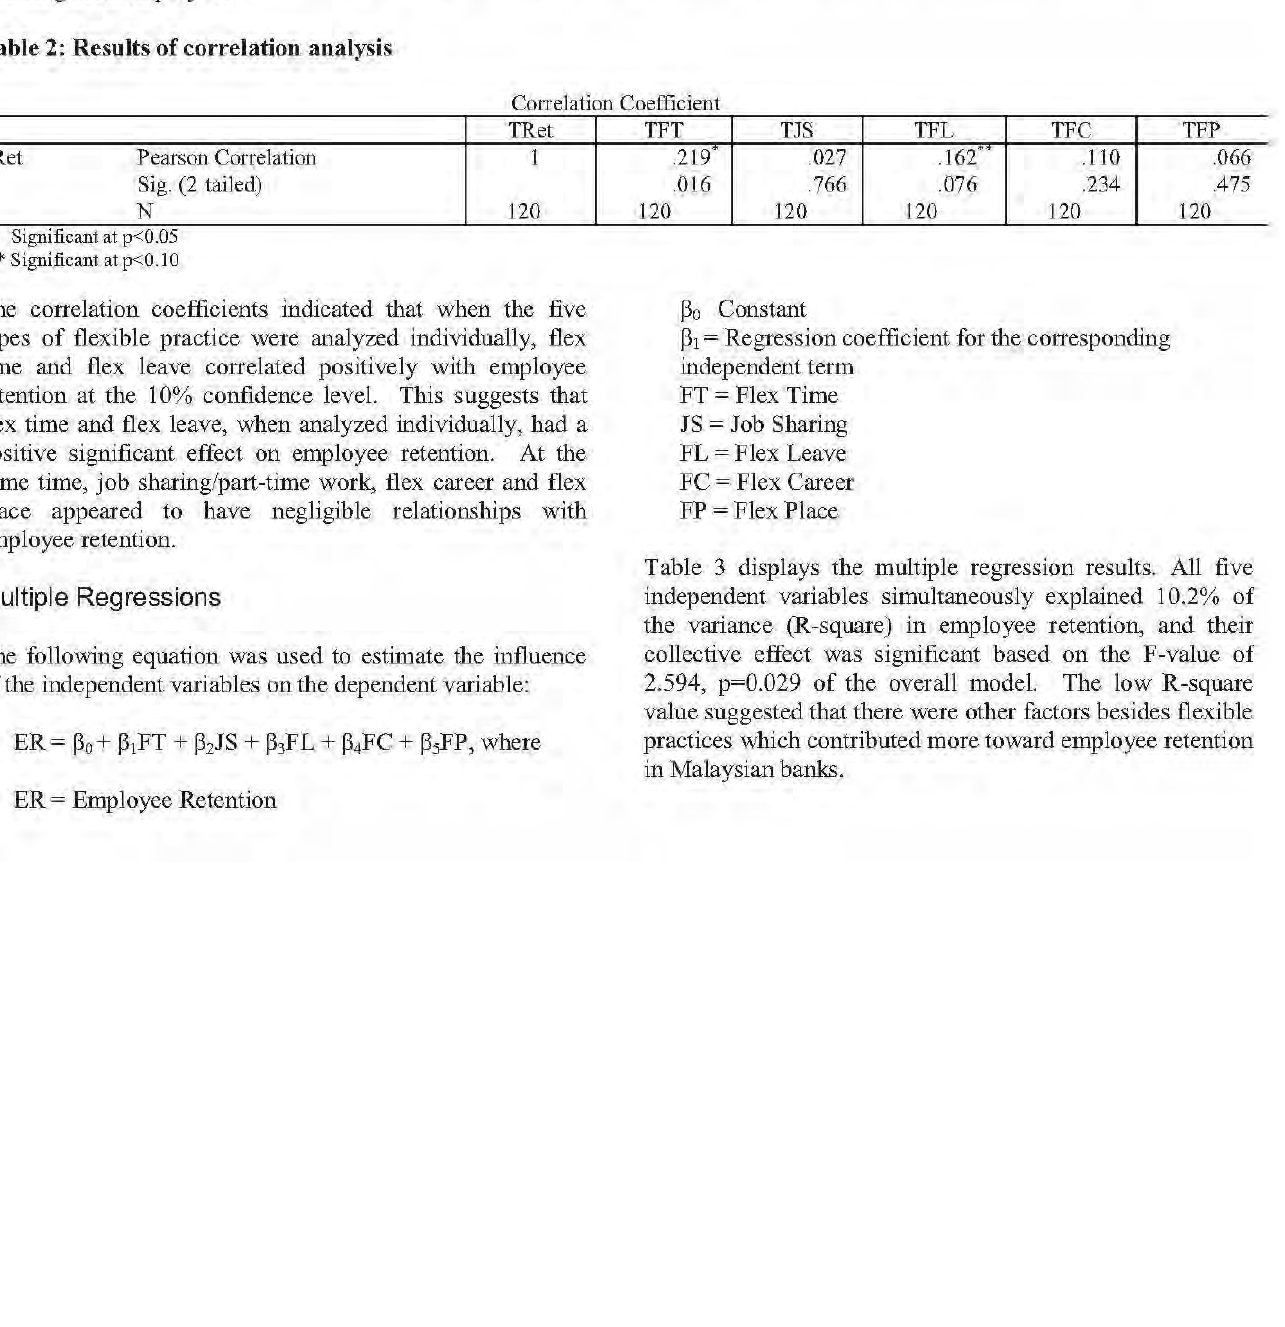
Table 2: Results of correlation